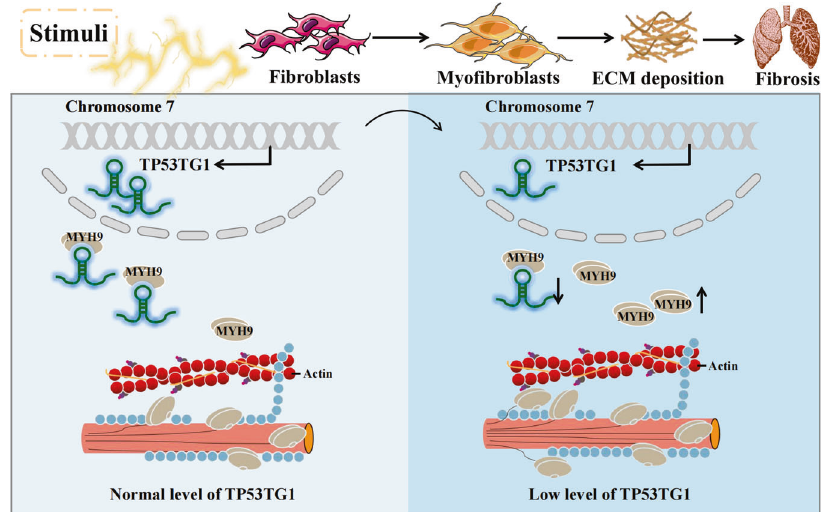
Fig. 8 Graphic illustration of TP53TG1 mechanism. TP53TG1 binds to the Myosin Heavy Chain 9 (MYH9) to decrease its protein expression and thus the MYH9-mediated activation of fi broblasts.